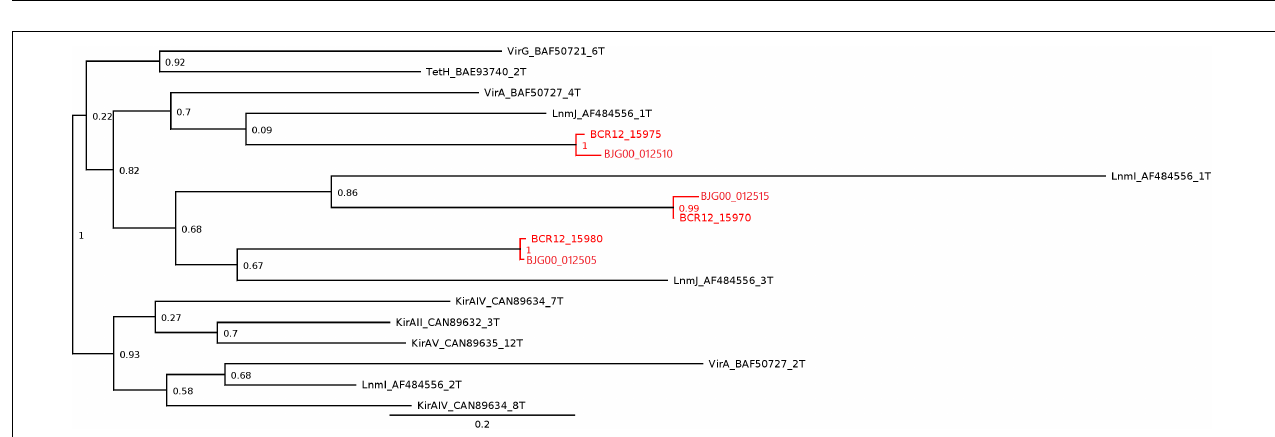
FIGURE 9 | Domains present in trans -AT PKS cluster found in Limnothrix sp. CACIAM 69d and Limnothrix sp. P13C2. The results are presented according to antiSMASH 4.0 output. The red circle indicates a domain present only in P13C2 strain and the purple circle a domain found only in CACIAM 69d strain. The order of the CDS for CACIAM 69d and P13C2 is shown at the bottom. ACP, acyl carrier protein; AT, acyltransferase domain; C, condensation domain; DH, dehydratase domain; ER, enoyl reductase domain; KR, keto reductase domain; KS, keto synthase domain; MT, methyl transferase domain; TE, thioesterase domain.